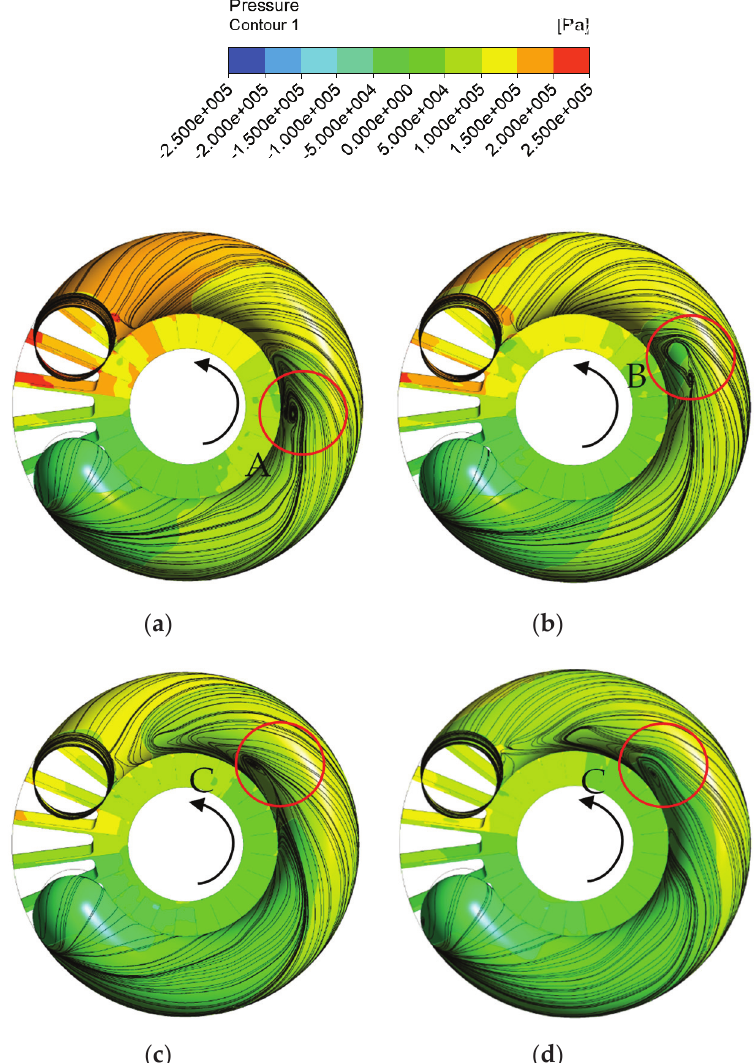
Figure 12. Pressure and velocity streamlines in side channel wall ( a ) single phase, ( b ) IGVF 2%, ( c ) IGVF 4%, ( d ) IGVF 6%.